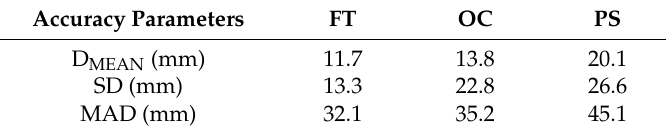
Table 2. Accuracy of the LMC for FT, OC and PS